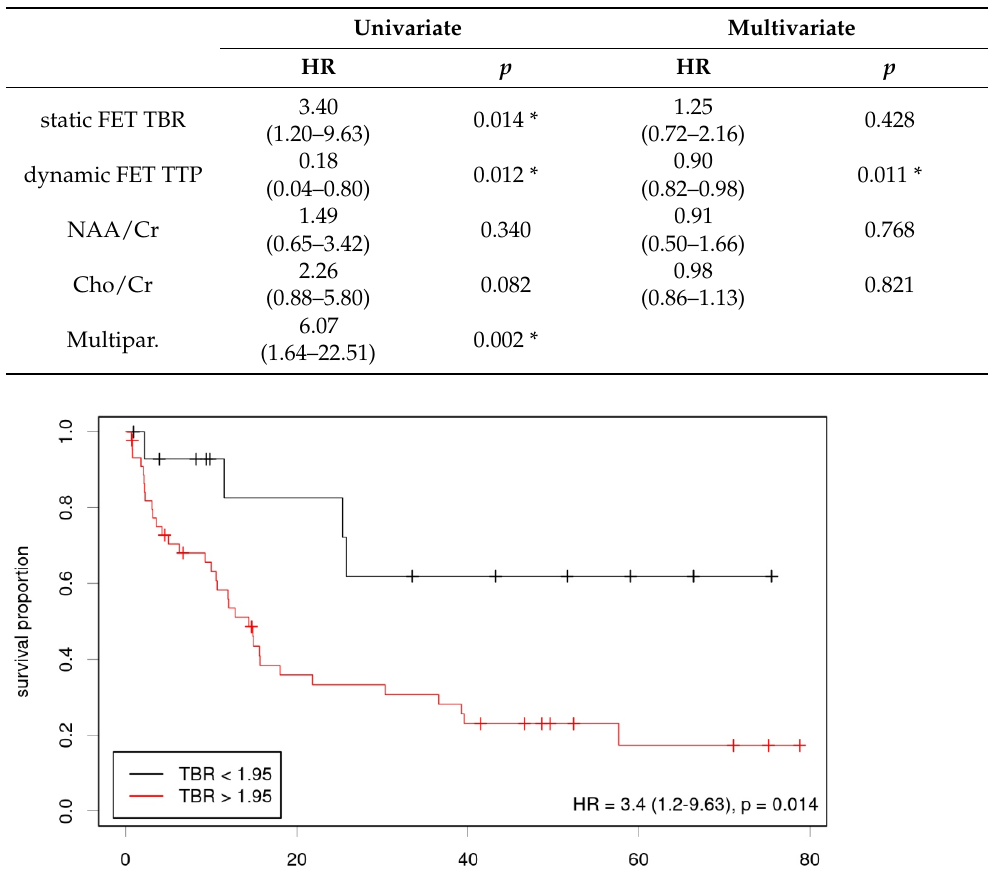
Figure 4. Kaplan–Meier plot showing low- and high-risk groups according to static FET-PET (TBR).